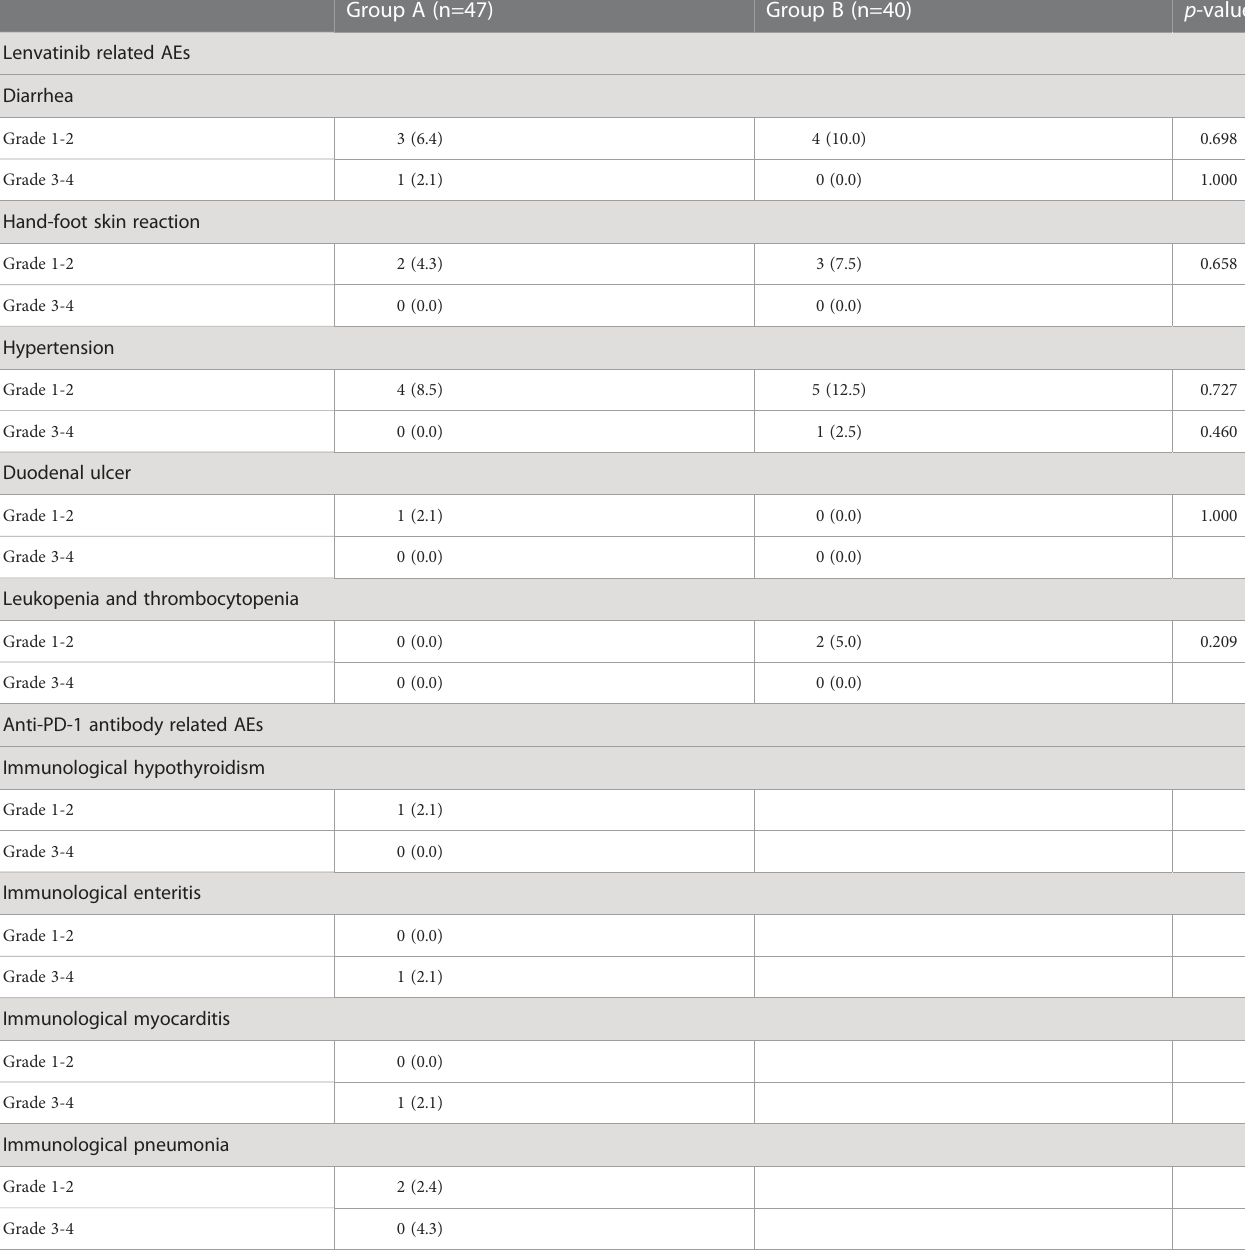
TABLE 5 Adverse events related to systemic therapy in 2